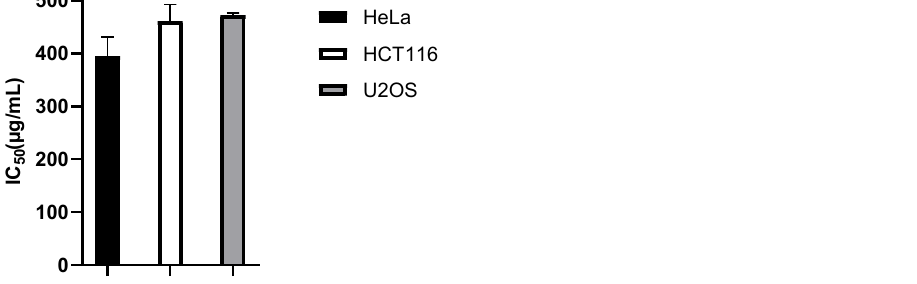
Figure 5. Antiproliferative activity of methanol extract of P. ramosissima on HeLa, HCT116, and U2OS cancer cell lines expressed as mean IC 50 values after three independent experiments ± SD (standard deviation). Statistical analysis was performed using a one-way ANOVA test followed by Tukey’s multiple comparison test. No statistically significant difference was found.